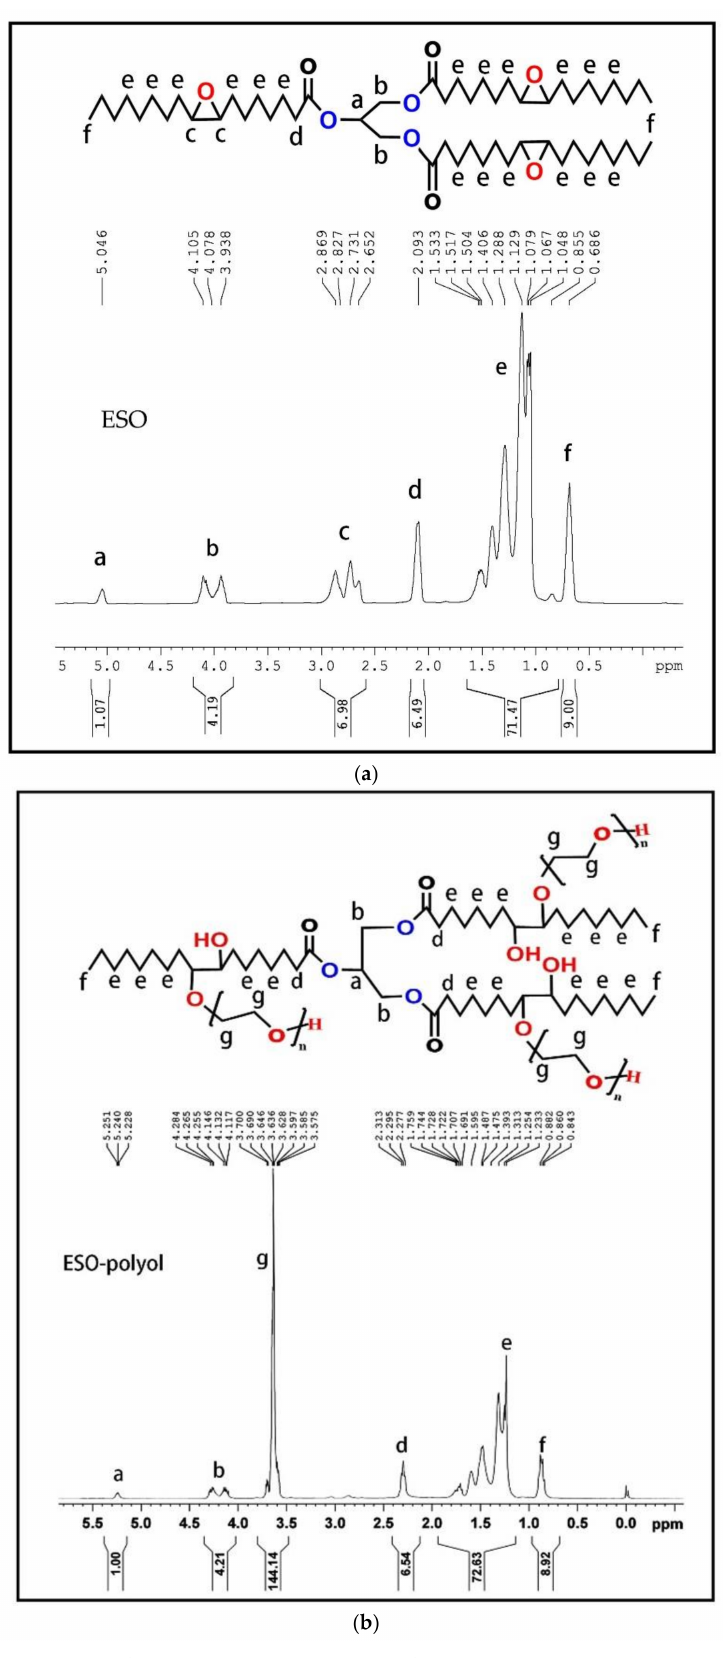
Figure 4. ( a ) 1 H NMR spectra of ESO, ( b ) 1 H NMR spectra of